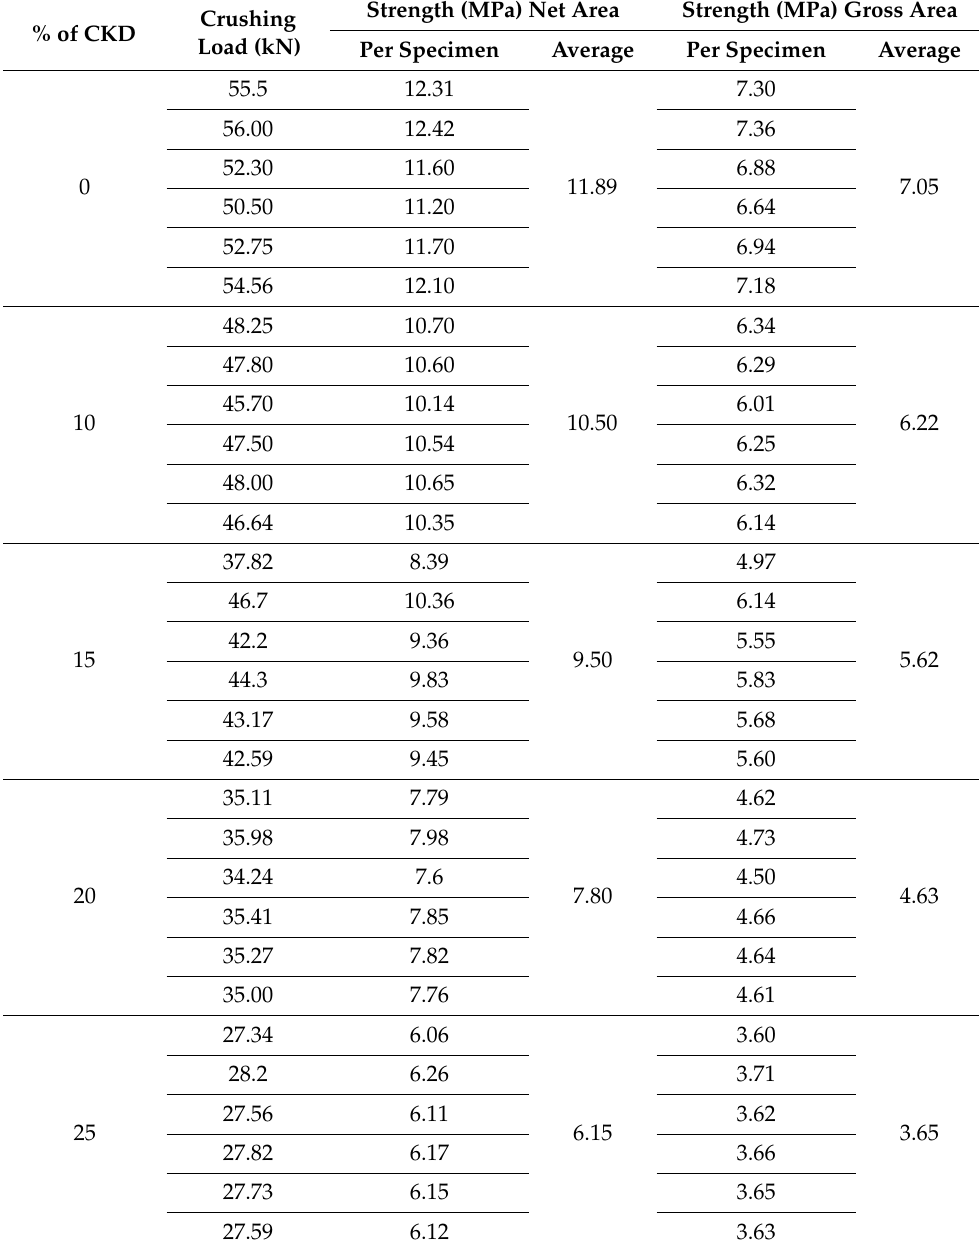
Table 6. Hollow block compressive strength results. % of